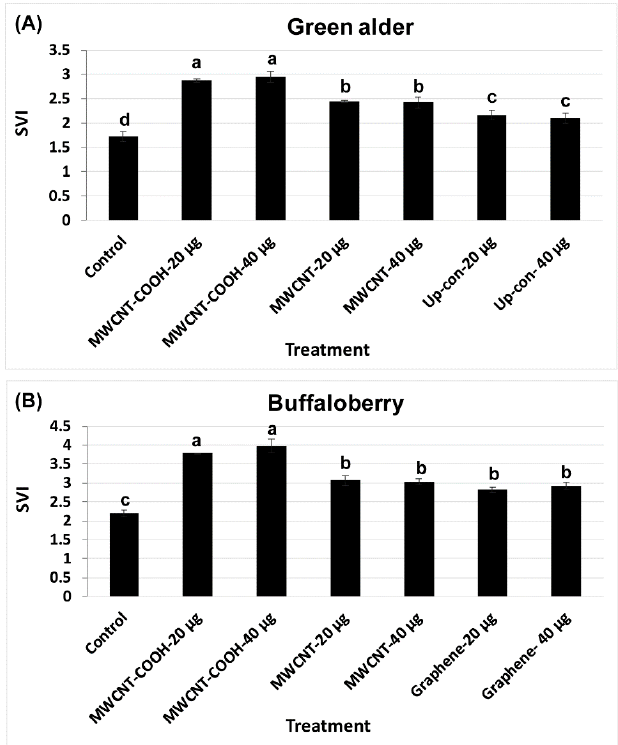
Figure 6. Seedling vigor index (SVI) in green alder ( A ) and buffalo berry ( B ) upland boreal forest species. Values in bar chart represent means ± standard errors and are significantly different at α = 0.05. Control = no CNPs added. MWCNT–COOH = multiwall carbon nanotubes functionalized with carboxylic acid, MWCNT = multiwall carbon nanotubes, up-con = up conversion nanophosphors. N = 100 plants per